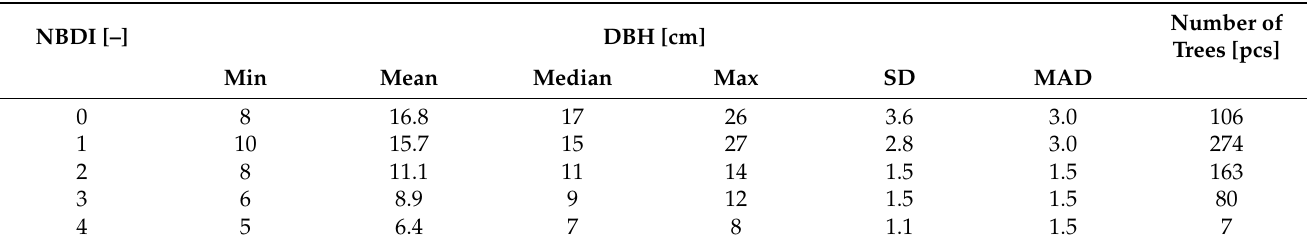
Table 1. The values of minimum, arithmetic mean, median, maximum, standard deviation (SD) and median absolute deviation (MAD) were calculated from DBH for different NBDI.